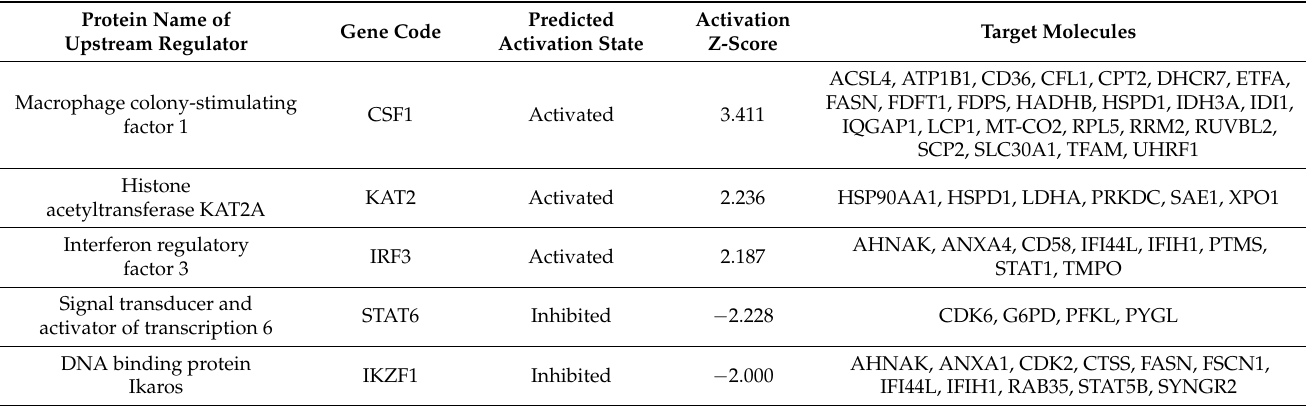
Figure 5. Protein–protein interaction network of significantly up- and downregulated proteins following ABC treatment in LCL721.221/sHLA-B*57:01 cells compared to parental LCL721.221 cells and cellular processes they are involved in (based on GO/KEGG). Network was constructed by STRING Database (Version 11.5) and visualized using Cytoscape (Version 3.8.2). Significant regulated proteins ( p < 0.05) at least altered by a factor of log 2 ± 0.5 were considered. Upregulated proteins are illustrated in red; downregulated proteins are depicted in green. Color intensity reflects the log 2 -fold difference between LCL721.221/sHLA-B*57:01 cells compared to parental LCL721.221 cells. Table 3. Upstream regulator of significantly up- and downregulated proteins in LCL721.221/sHLA- B*57:01 cells compared to parental cells following ABC treatment.